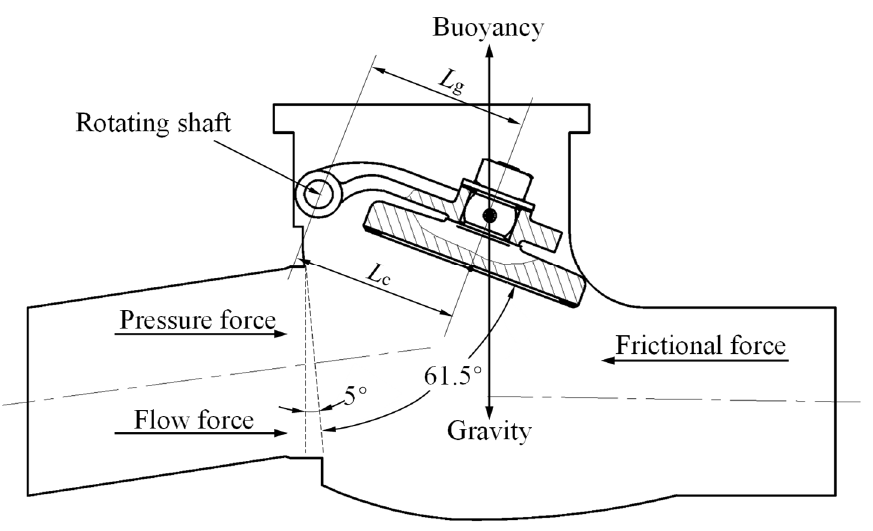
Figure 3. Force analysis of valve motion components.